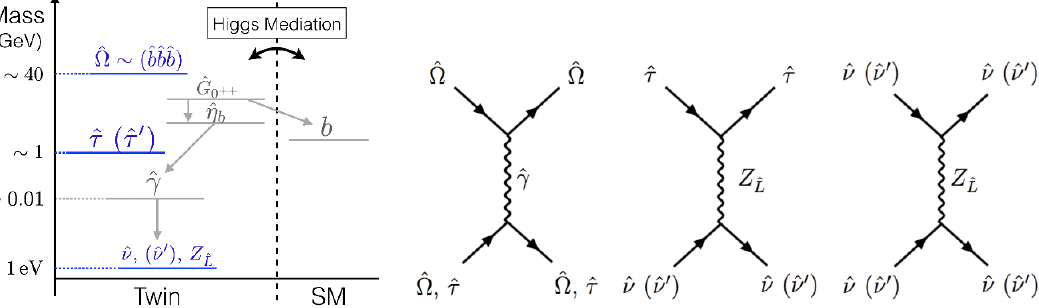
Figure 1 . Left: a representation of the particle spectrum in the extended Twin Higgs model under consideration. The blue (gray)-colored particles correspond to the stable (unstable) members of the spectrum. The gray arrows indicate the decay products of the unstable particles. Further, the primed (cid:12)elds correspond to the set of speci(cid:12)c anomaly compensators used in this paper. Right: the set of dominant processes involved in the solution of the large- and small-scale structure anomalies. The (cid:12)rst Feynman diagram represents the dominant process relevant for the self-interacting dark matter scenario through the exchange of twin photons. The second diagram corresponds to the relevant scattering for the partially acoustic oscillation scenario, and the third one is the process that keeps the dark radiation a tightly coupled